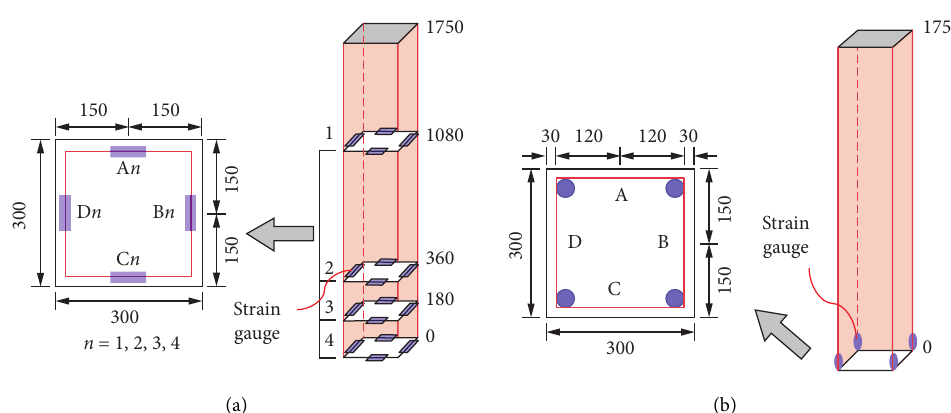
Figure 6: Locations of strain gauges embedded in stirrups and longitudinal bars (/mm). (a) Stirrups. (b) Longitudinal bars.